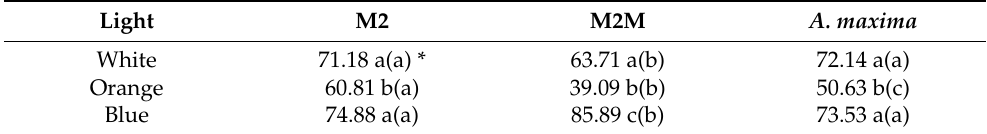
Table 2. Average protein content (g 100 g − 1 ± RSD DW) in the different experimental conditions of the three strains.